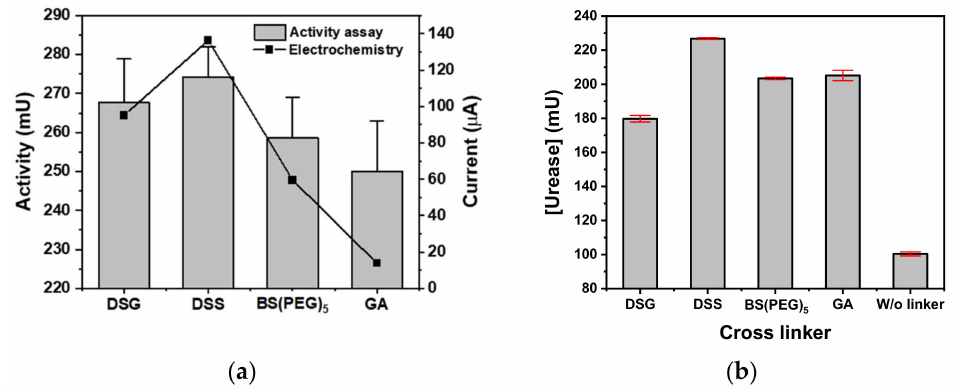
Figure 2. Urease activity of the cross-linker urease-immobilized parylene-A coated ( a ) microplate and ( b ) PTFE membrane measured using a commercial urea assay kit (gray bar) and electrochemistry ( (cid:4)